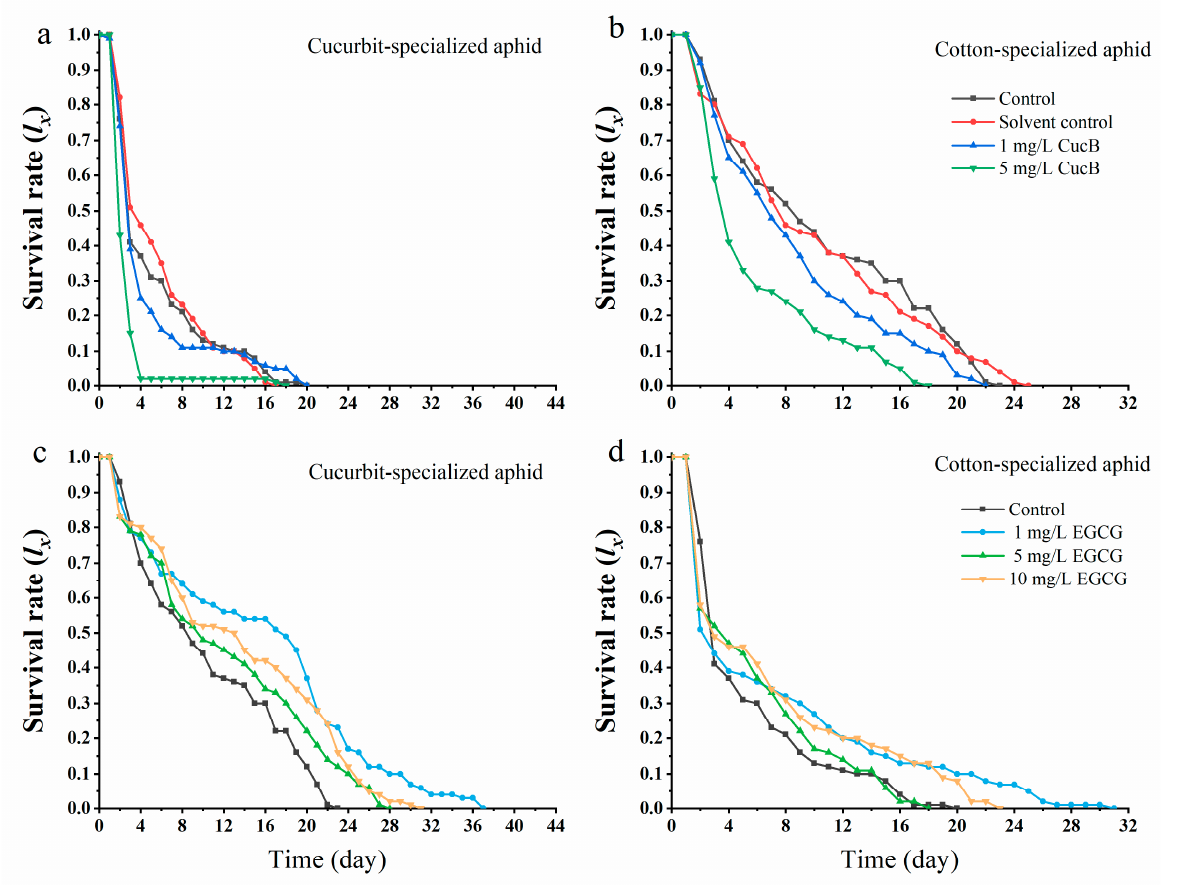
Figure 2. Survival rate ( l x ) of Aphis gossypii on nonhost plants when the maternal generation is exposed to CucB and EGCG. ( a ): CUS exposed to CucB; ( b ): COS exposed to CucB; ( c ): CUS exposed to EGCG; ( d ): COS exposed to EGCG.